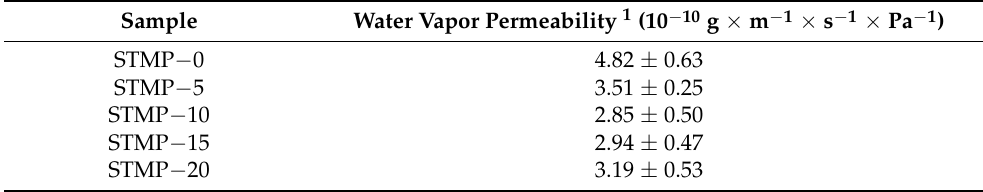
Table 5. Water vapor permeability of STMP crosslinked hemicellulose films 1.